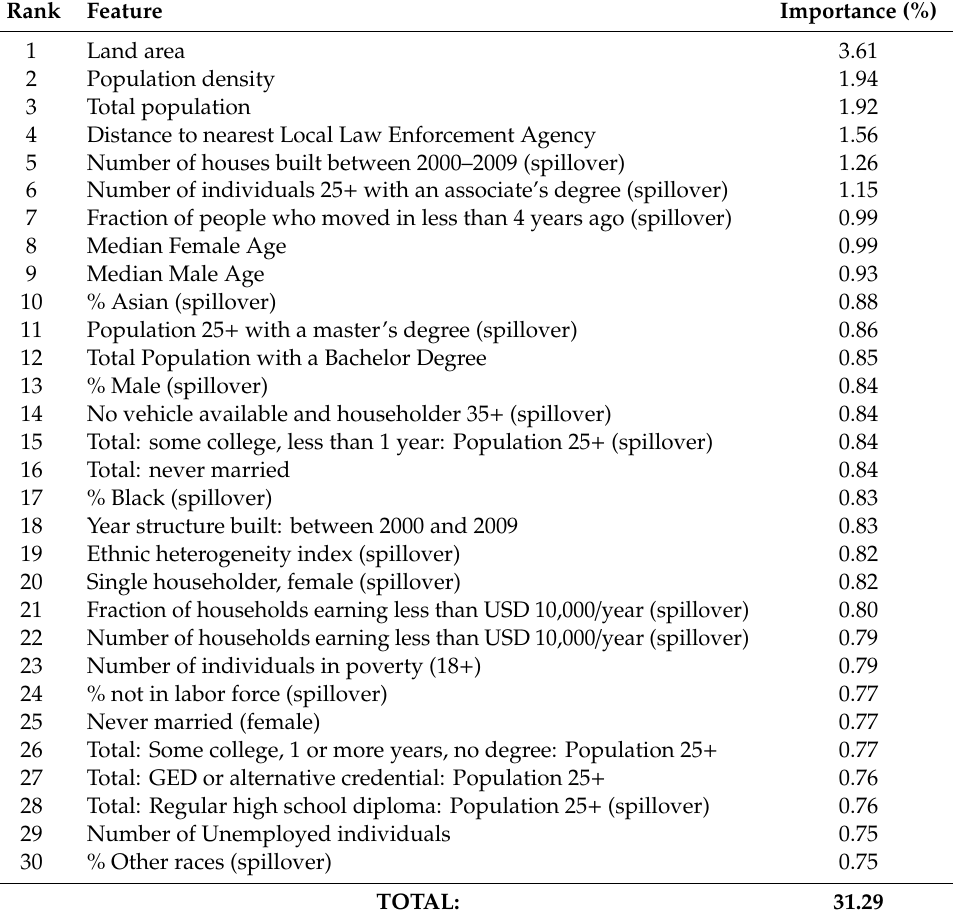
Table 7. The 30 features with the highest importance, based on the gradient boosting